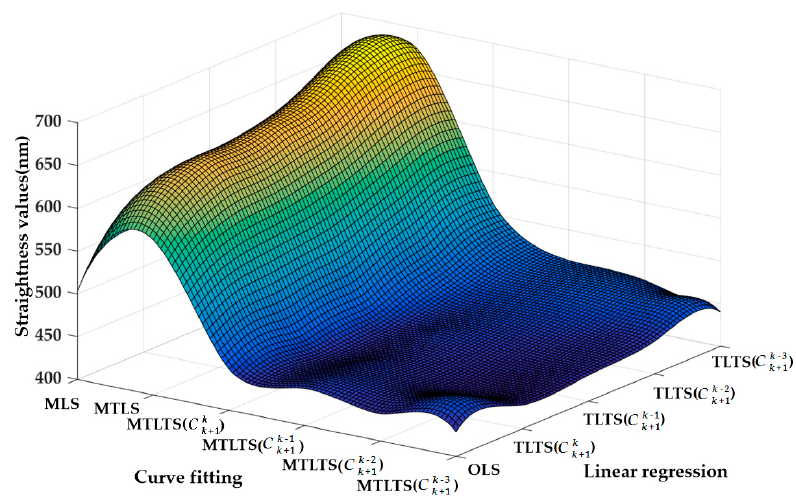
Figure 11. The trend of the straightness value.